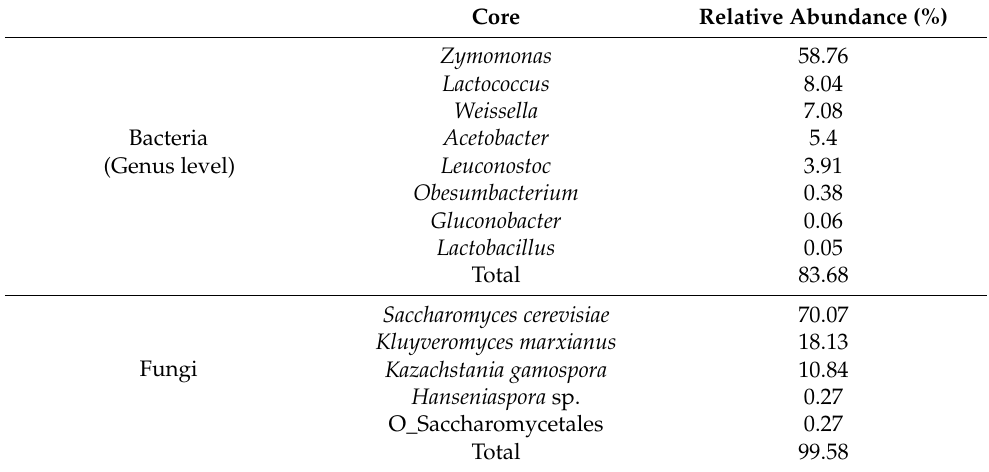
Table 3. The proposed microbial core for pulque fermentation present in all the analyzed